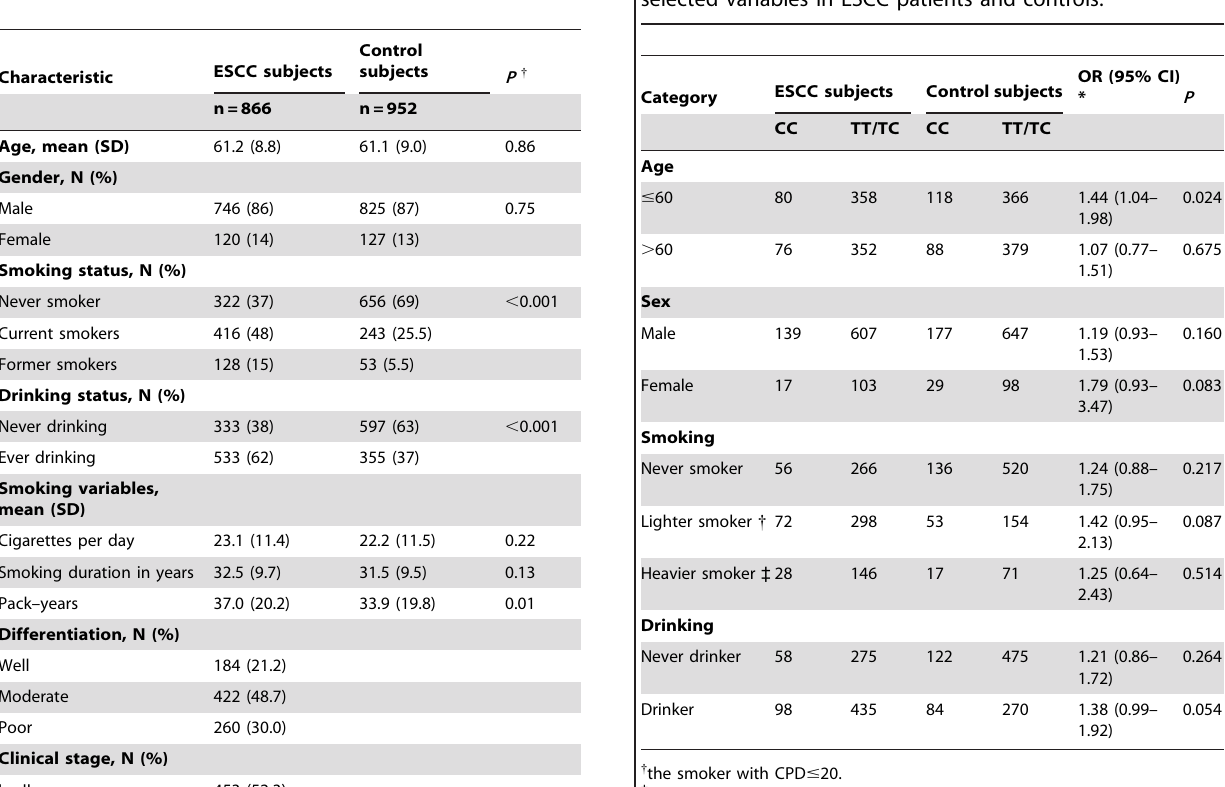
Table 1. The baseline characteristics of the study population.